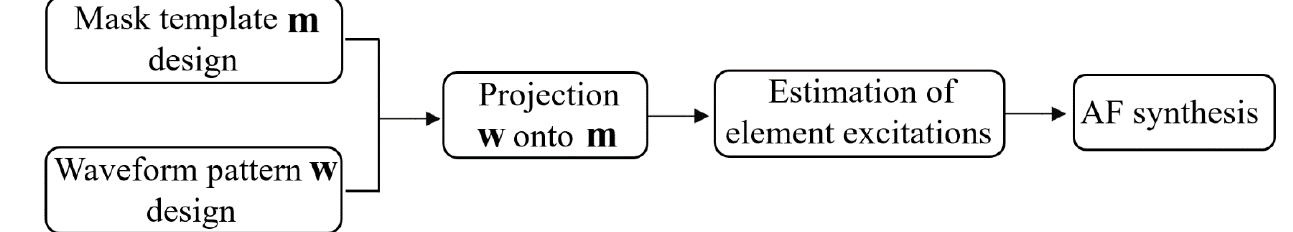
Figure 1. Overall flowchart of the proposed approach for APS.